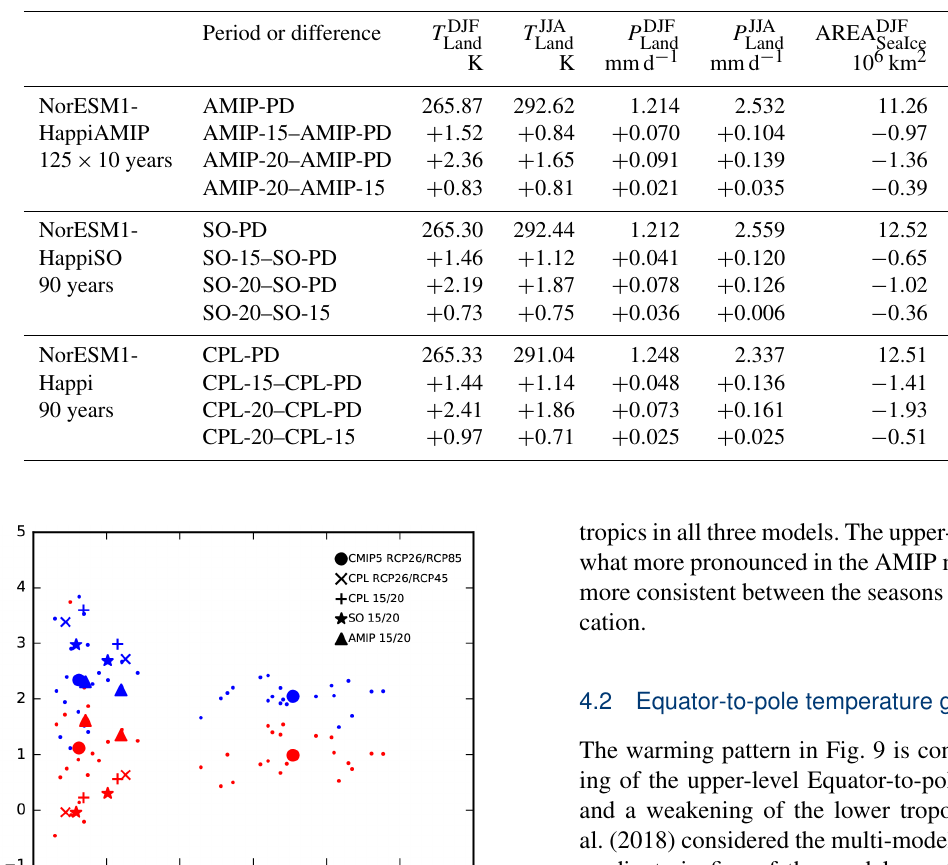
Table 4. Similar to Table 3 but for near-surface temperature over land, precipitation on land, and sea-ice area in the NH (20–90 ◦ N) during winter (DJF) and summer (JJA).